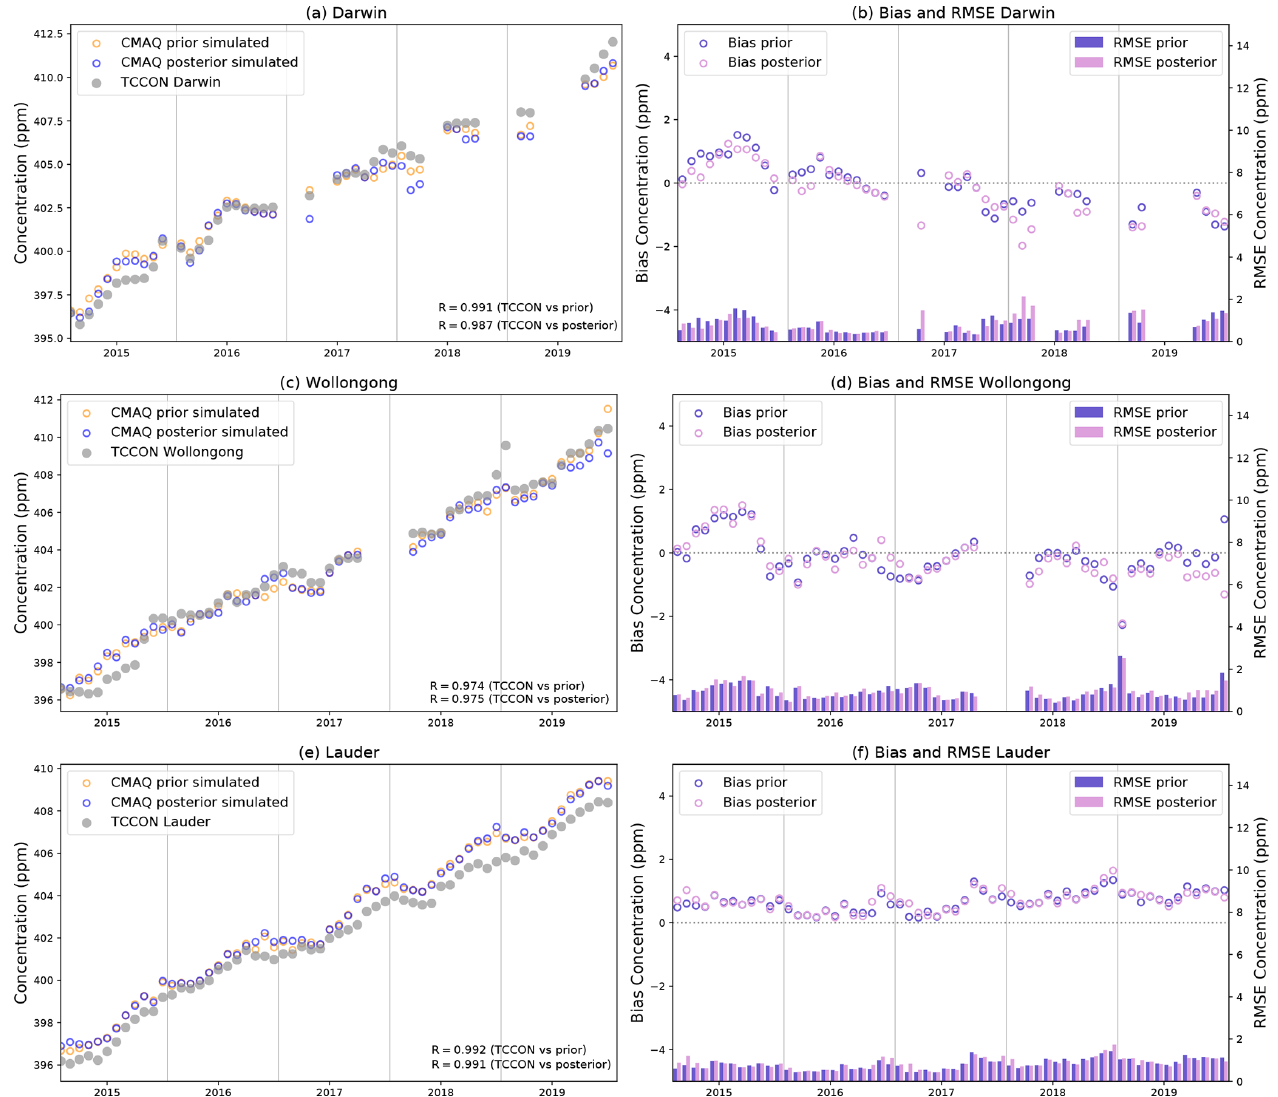
Figure 7. Comparison between the monthly mean column-averaged bias and root-mean-square error (RMSE) at the (a, b) Darwin, (c, d) Wollongong, and (e, f) Lauder TCCON sites and the CMAQ prior and posterior modelled CO 2 concentrations for 2015–2019. In panels (a) , (c) , and (e) , the orange and blue circles represent the respective prior and posterior mean concentrations, and the grey dots represent TCCON